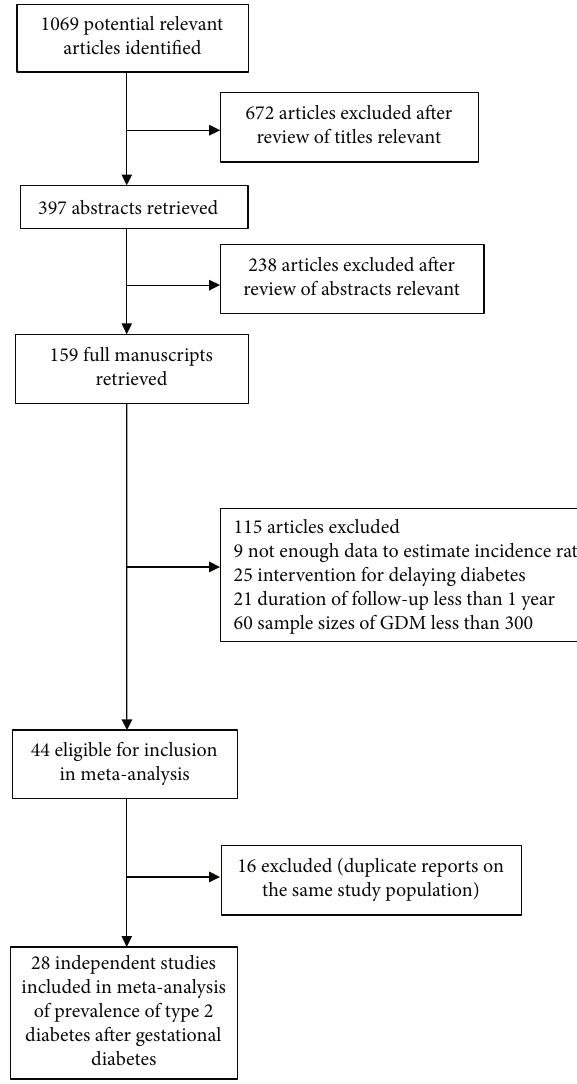
Figure 1: Flowchart of the selection of studies included in meta-